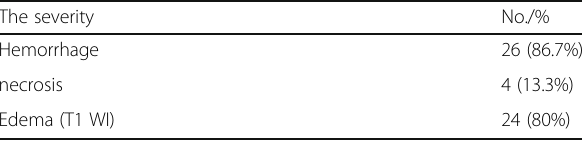
Table 3 Neuroimaging finding regarding the severity of ANEC in children The severity